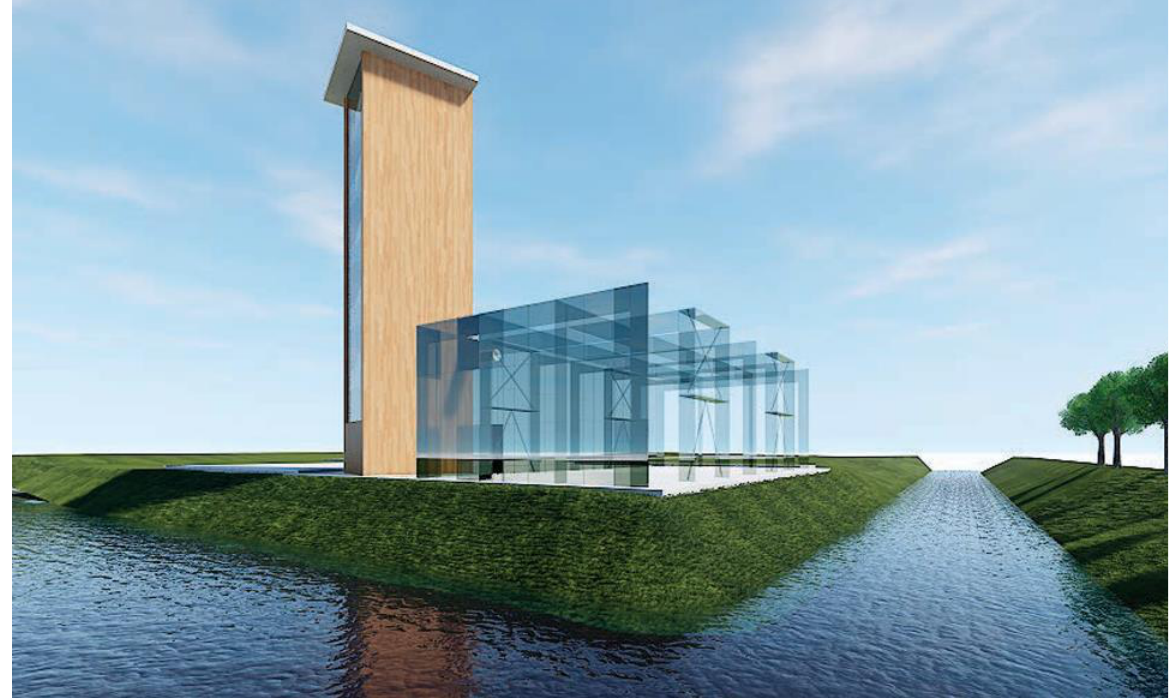
Fig. 1 3D impression of the first design (3D impression by Mecanoo, Delft).